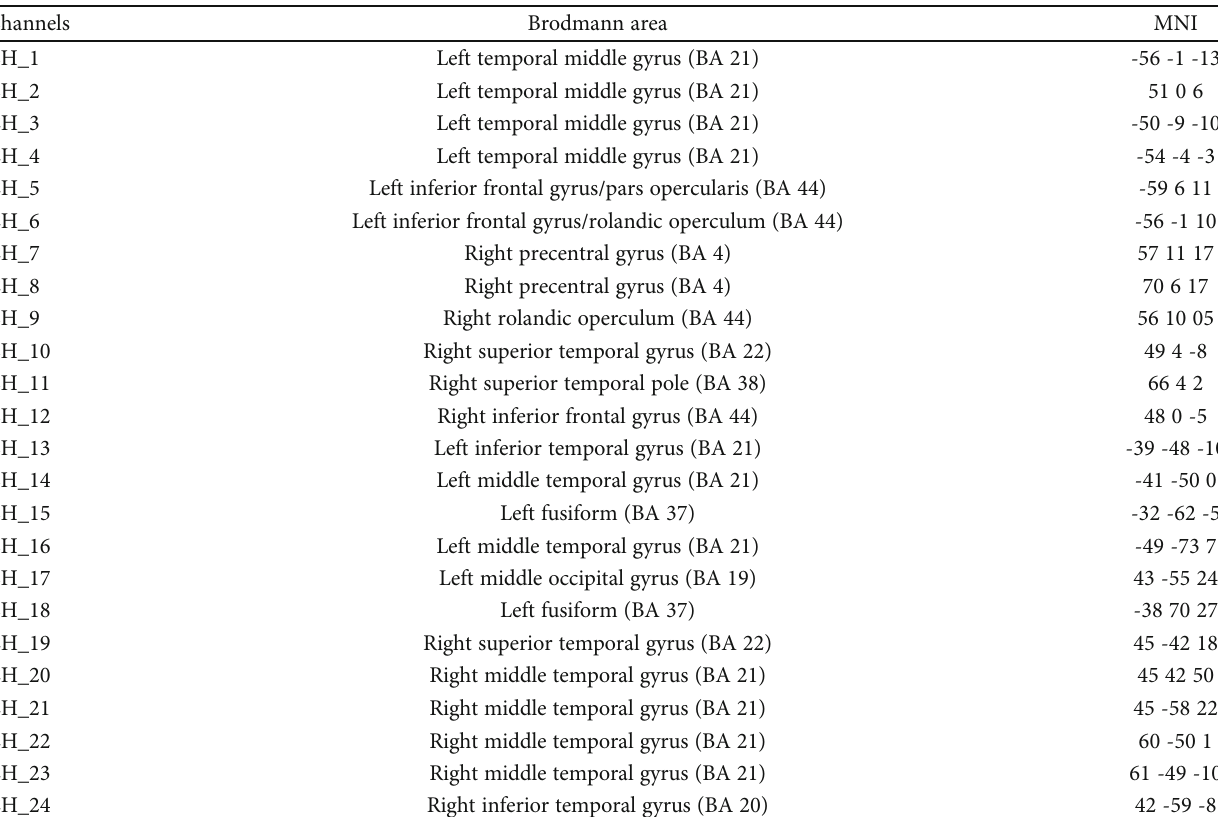
Table 3: Anatomic